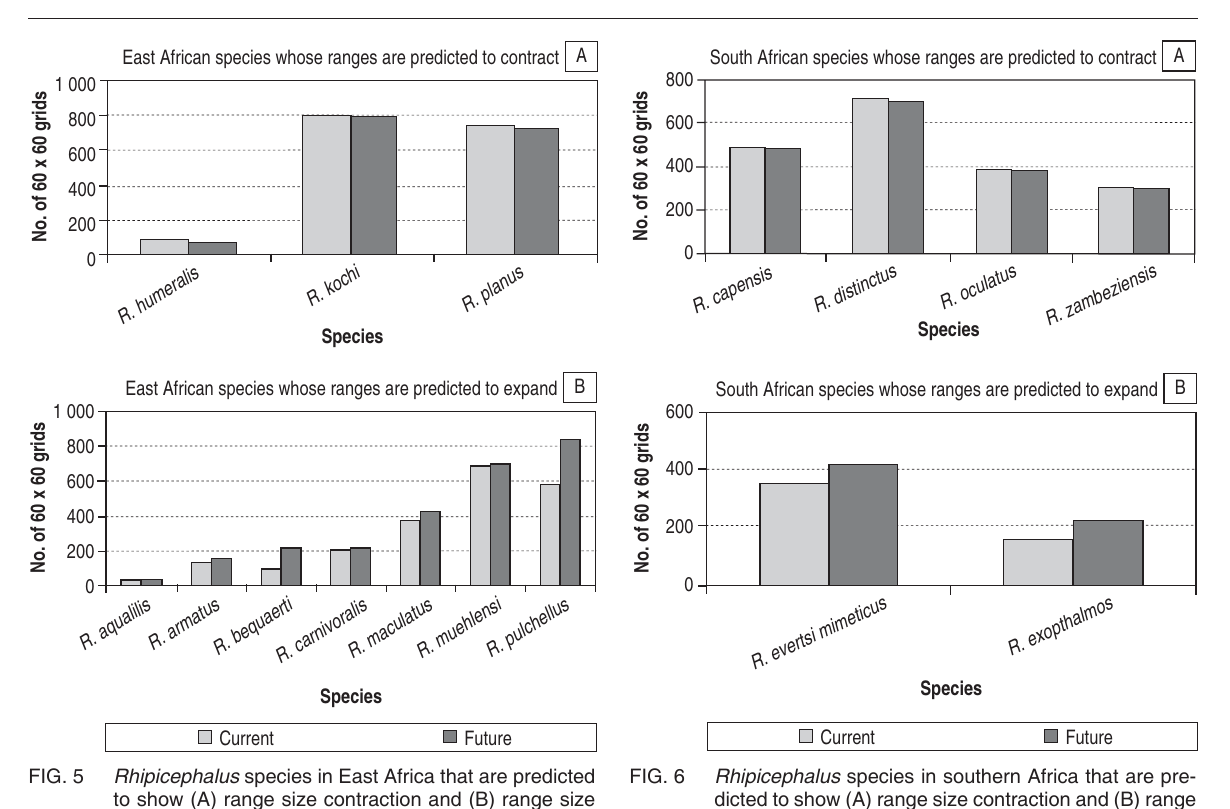
FIG. 6 Rhipicephalus species in southern Africa that are pre- dicted to show (A) range size contraction and (B) range size